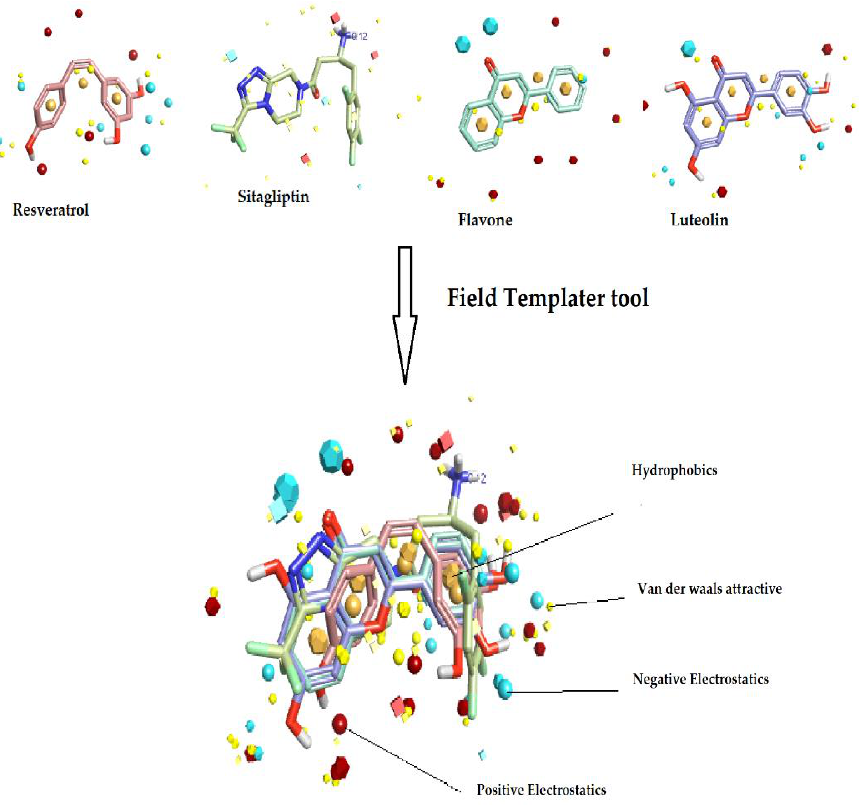
Figure 1. Representation of four template compounds inhibiting DPP-4 activity and identification of three-dimensional bioactive conformations on the basis of field points generated using field template tool.